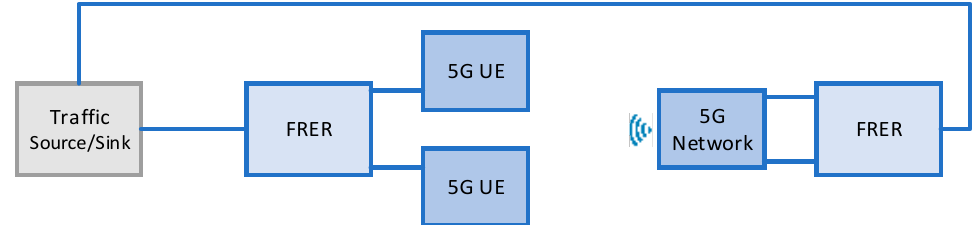
Figure 4. A simplified FRER setup where the application traffic at the ingress point is replicated and transmitted over two independent 5G user plane paths using two different UEs and is eliminated at the egress point.